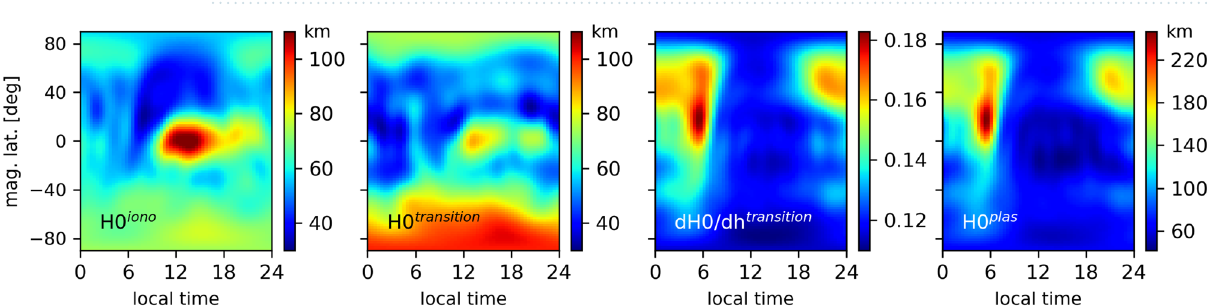
Figure 3. Same as Fig. 2, but using an interpolated H s at the transition region and Van Allen Probes H s at the plasmasphere.